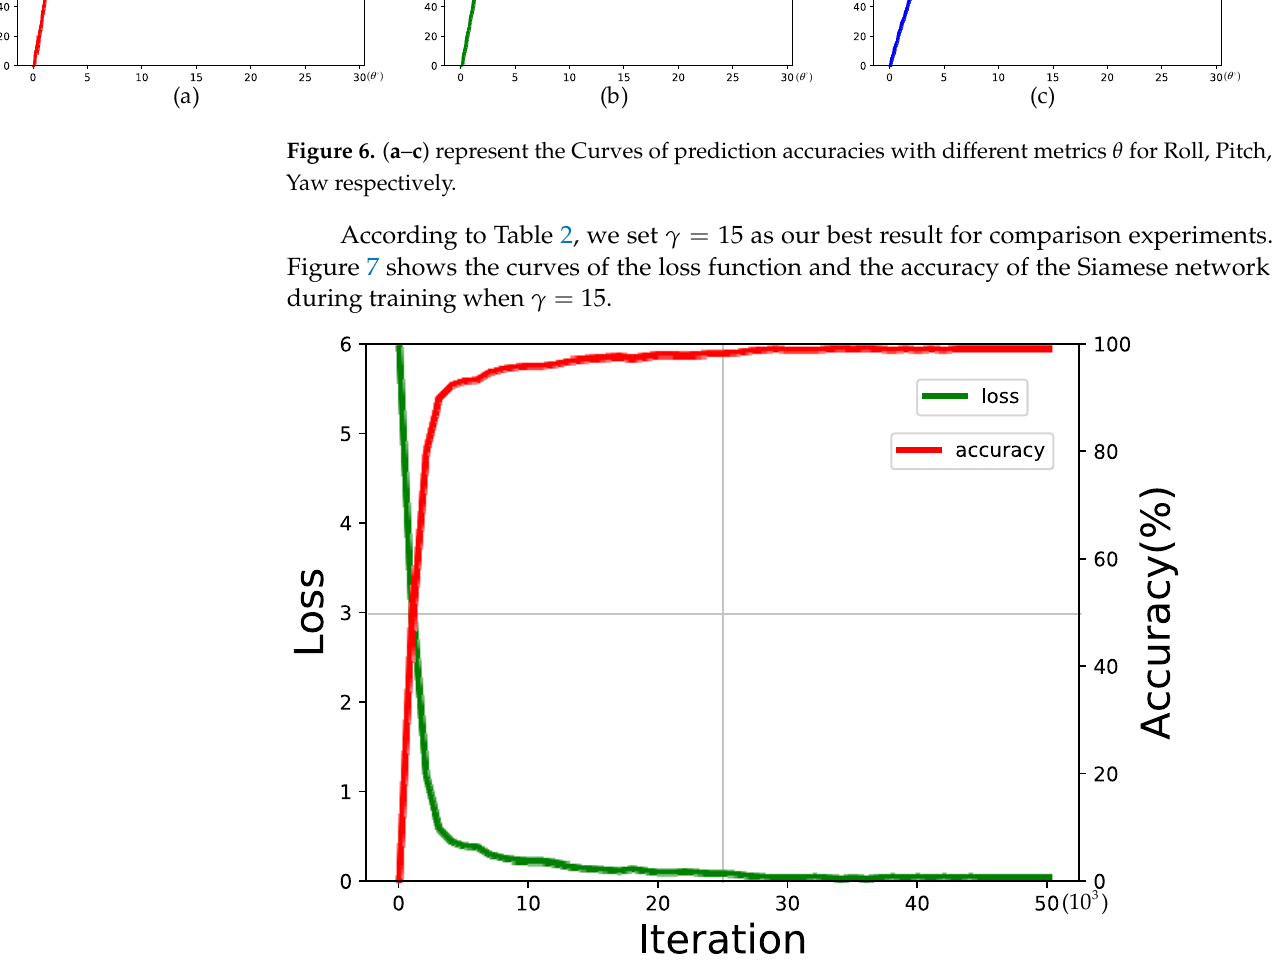
Figure 7. Curves of accuracy and loss when training our network at 15 γ= .